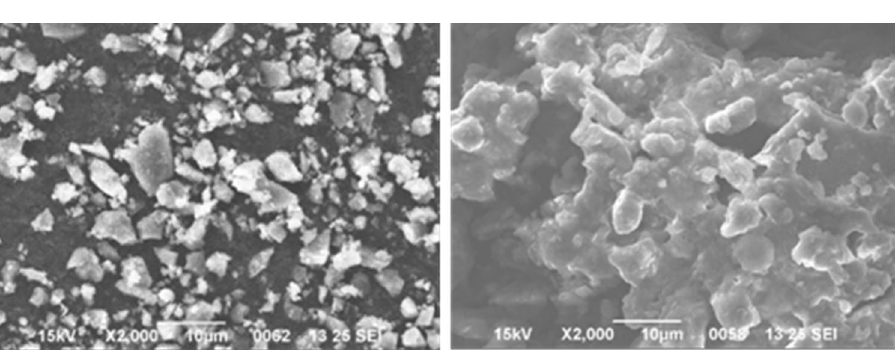
Figure 6. Scanning electron microscope images of S-13 (Left) and BR-2 (Right) verities of mulberry fruit pectin at 2000 ×